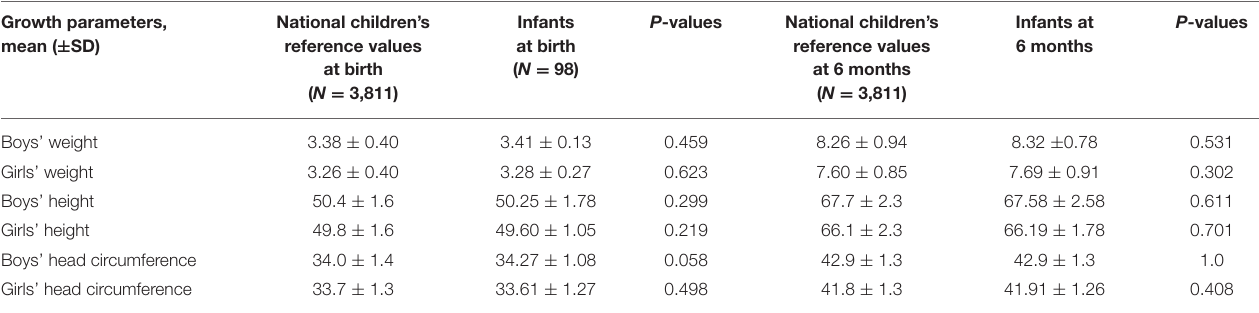
TABLE 2 | Growth parameters of infants with TAF exposure at birth and 6